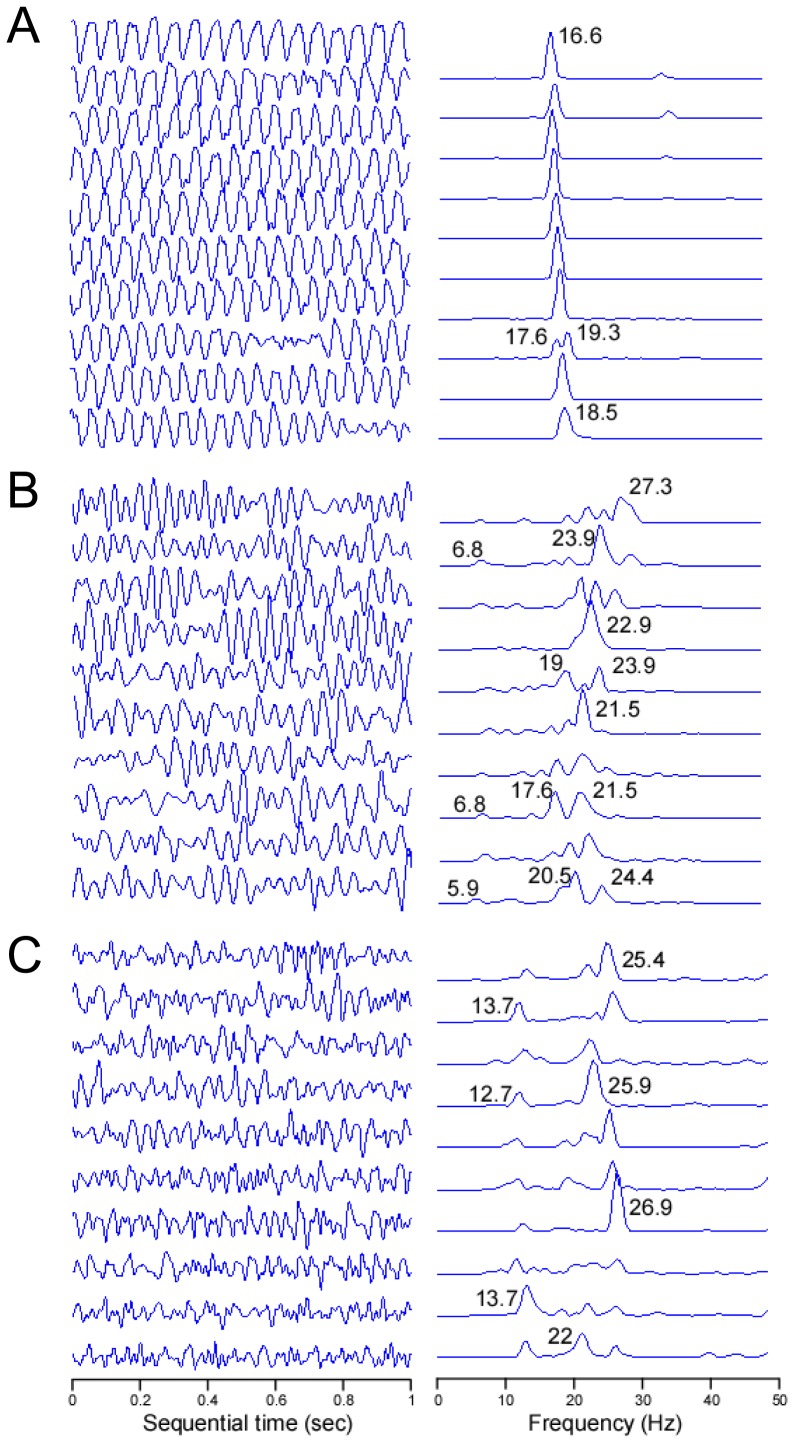
Time course of spectral properties of VF in a control and exercised sample rats.Ten consecutive 1-second long pseudo-ECG episodes of VF (from early at top to late at bottom) with their corresponding power spectra for sample animals from the CTRL (A), ST (B) and LT (C) groups, respectively. Numbers on power spectra traces indicate values of significant peaks in Hz.